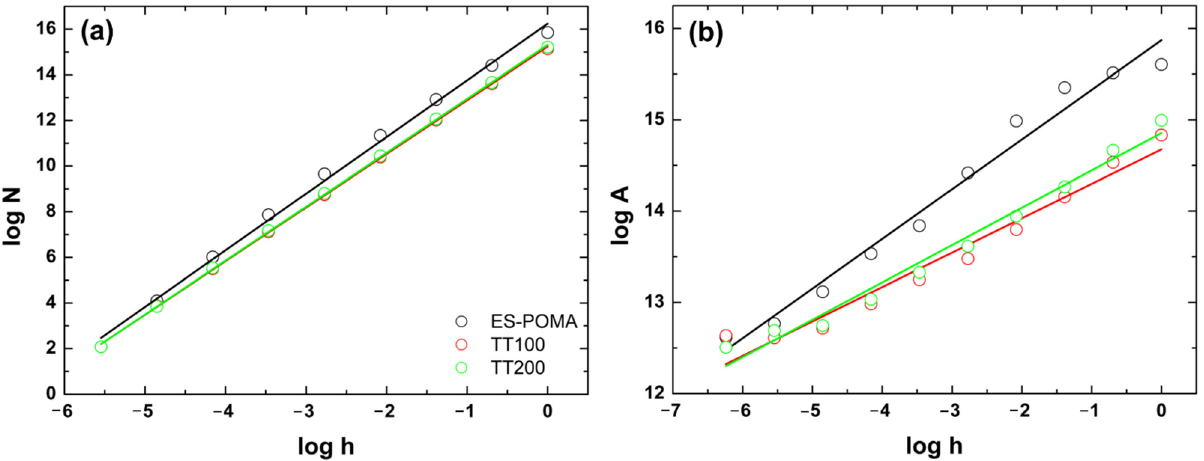
Figure 7. Fractal dimensions calculated as ( a ) cube counting and ( b )